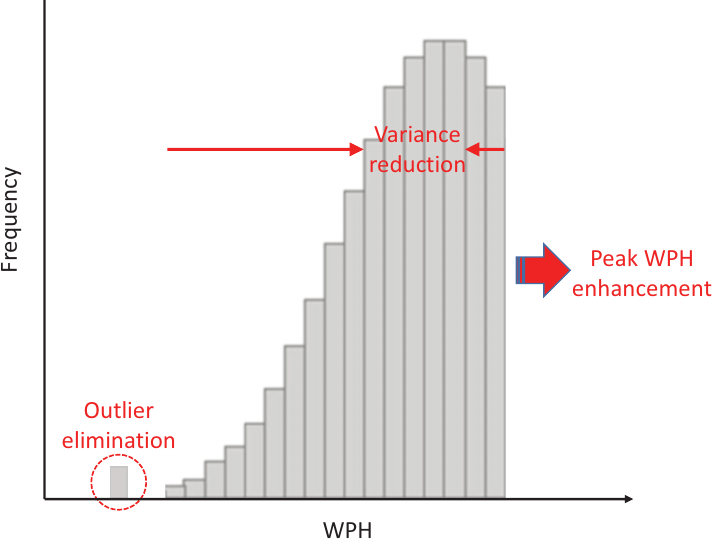
Figure 6. Primary goals of WPH improvement for critical equipment